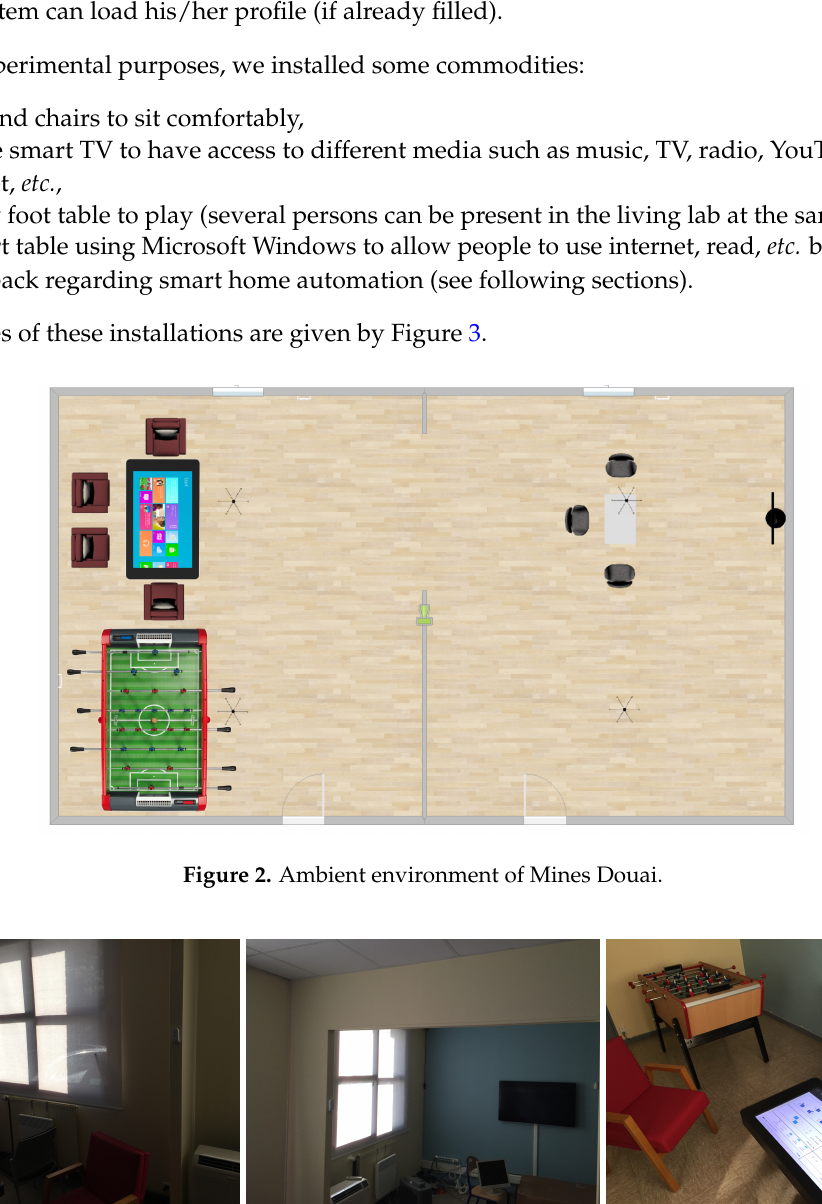
Figure 3. Installation in Mines Douai Living